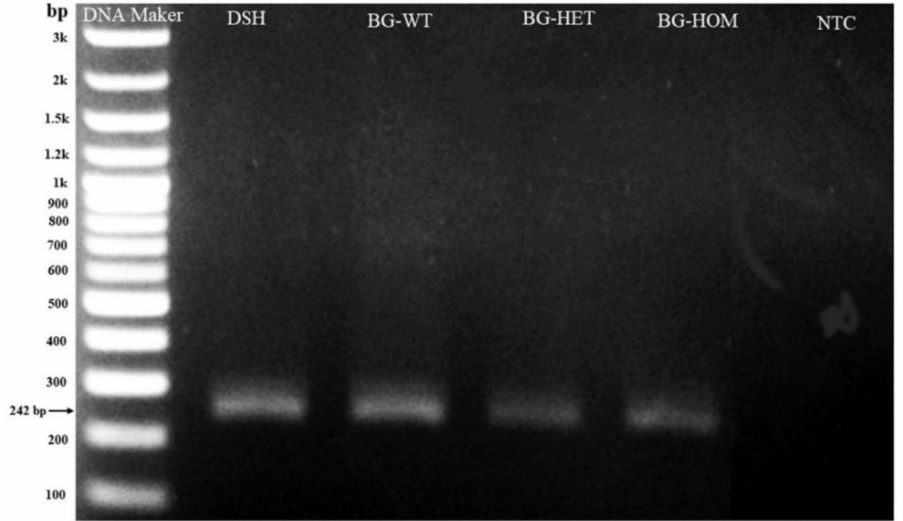
Figure 4. The results of gel electrophoresis. The size of the MYBPC3 gene from the PCR product was 242 bp. DSH = Domestic short hair; BG = Bengal cat; WT = wild-type; HET = heterozygous mutation; HOM = homozygous mutation; NTC = negative control; bp = base